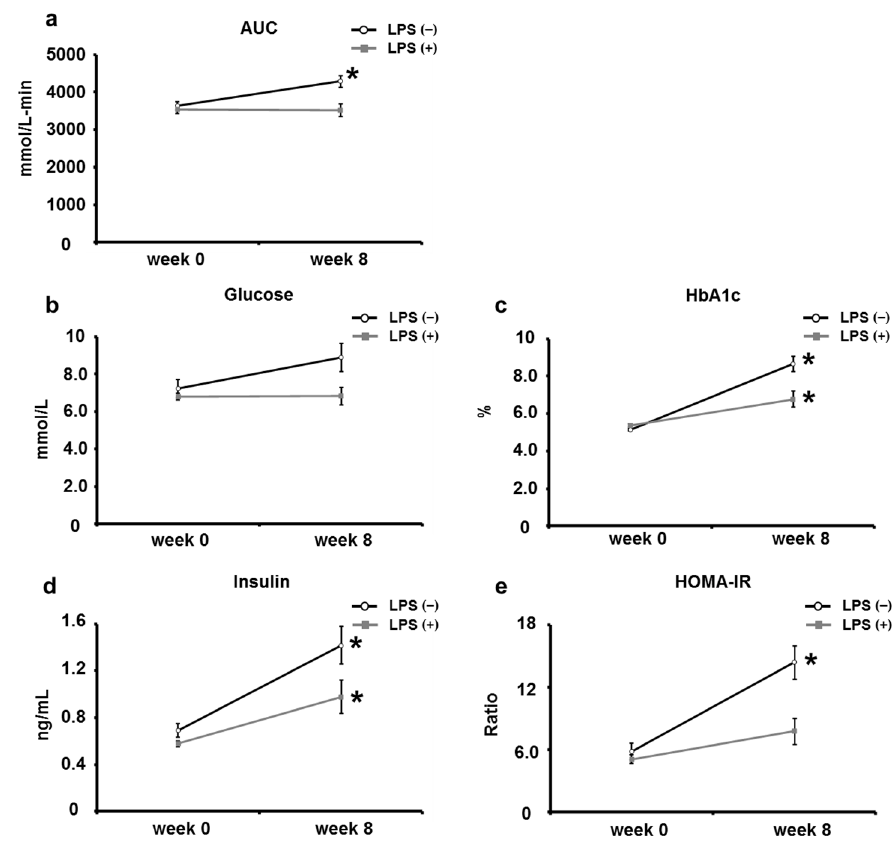
Figure 3. Comparison of OGTT response, glucose, HbA1c, insulin, and HOMA-IR before (week 0) and after (week 8) oral LPS administration. ( a ) The AUC of OGTT was calculated using the trapezoid rule ( n = 5–8). ( b ) The fasting glucose was measured using commercial kits ( n = 5–6). ( c ) The fasting HbA1c was measured by Oriental Yeast CO., Ltd. ( n = 5–6). ( d , e ) Insulin levels and HOMA-IR were measured using commercial kits ( n = 5–6). Values are presented as the mean ± SE. * p < 0.05 vs. mice before oral LPS administration (week 0).